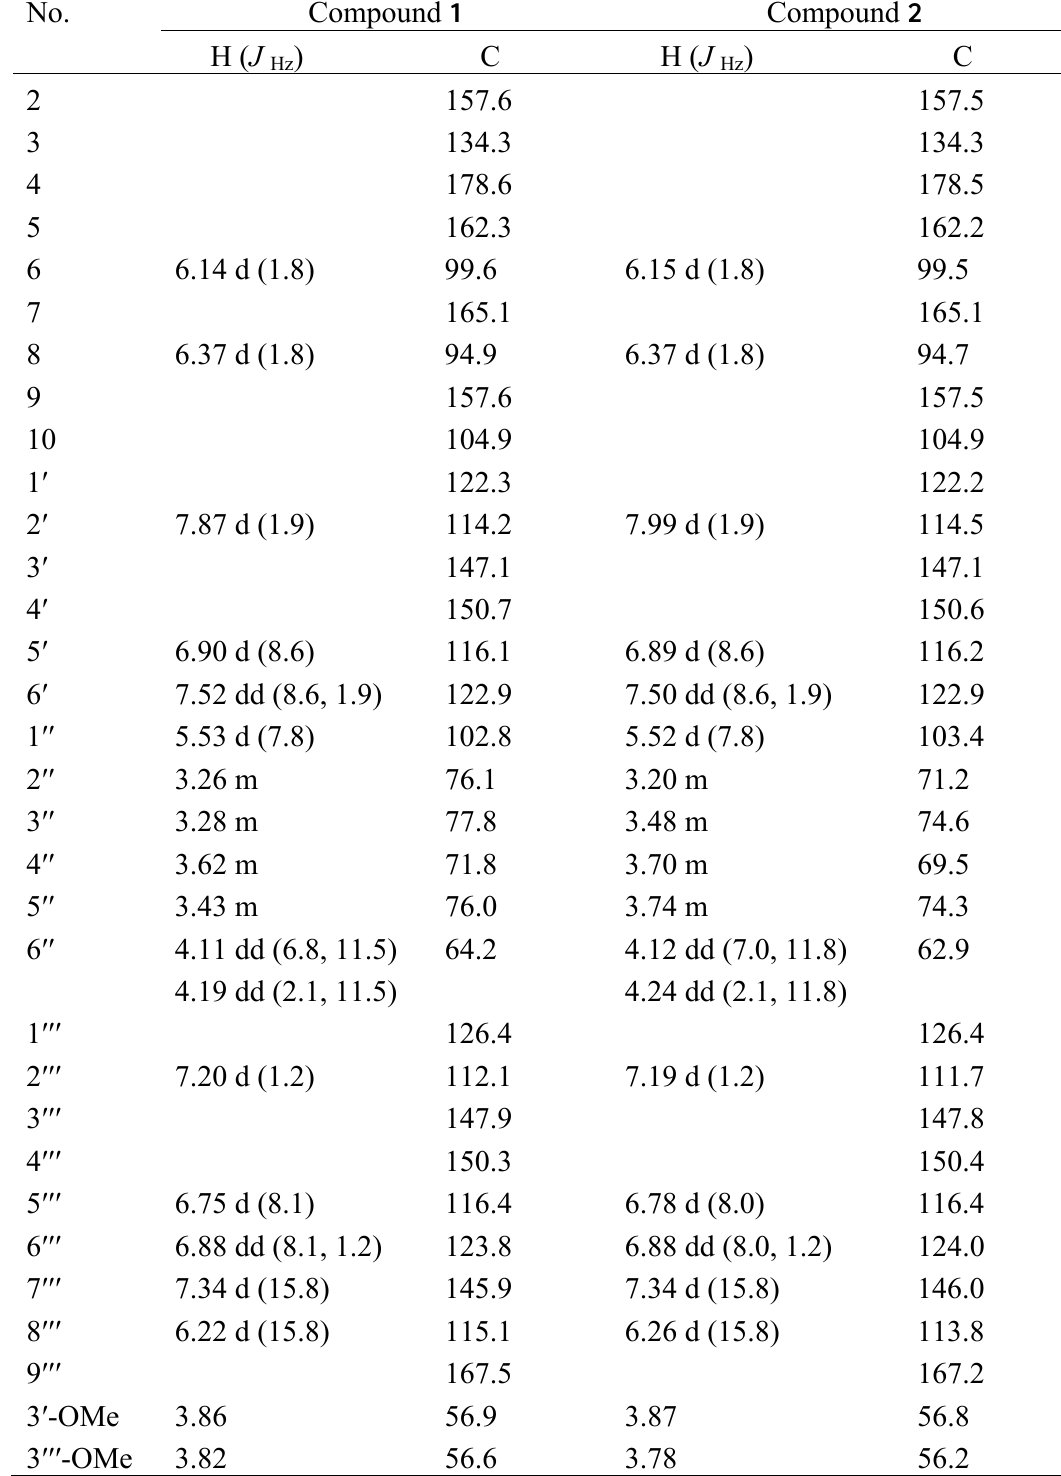
Table 1. The 1 H and 13 C-NMR data of compounds 1 and 2 (DMSO- d